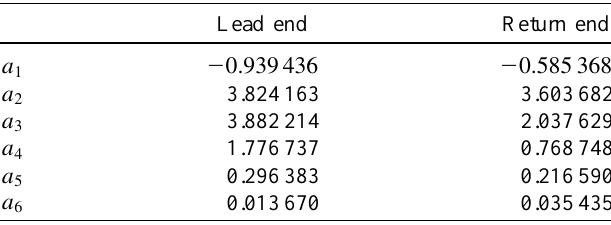
TABLE III. Enge coefficients fitted for the LHCHCQ lead and return ends,